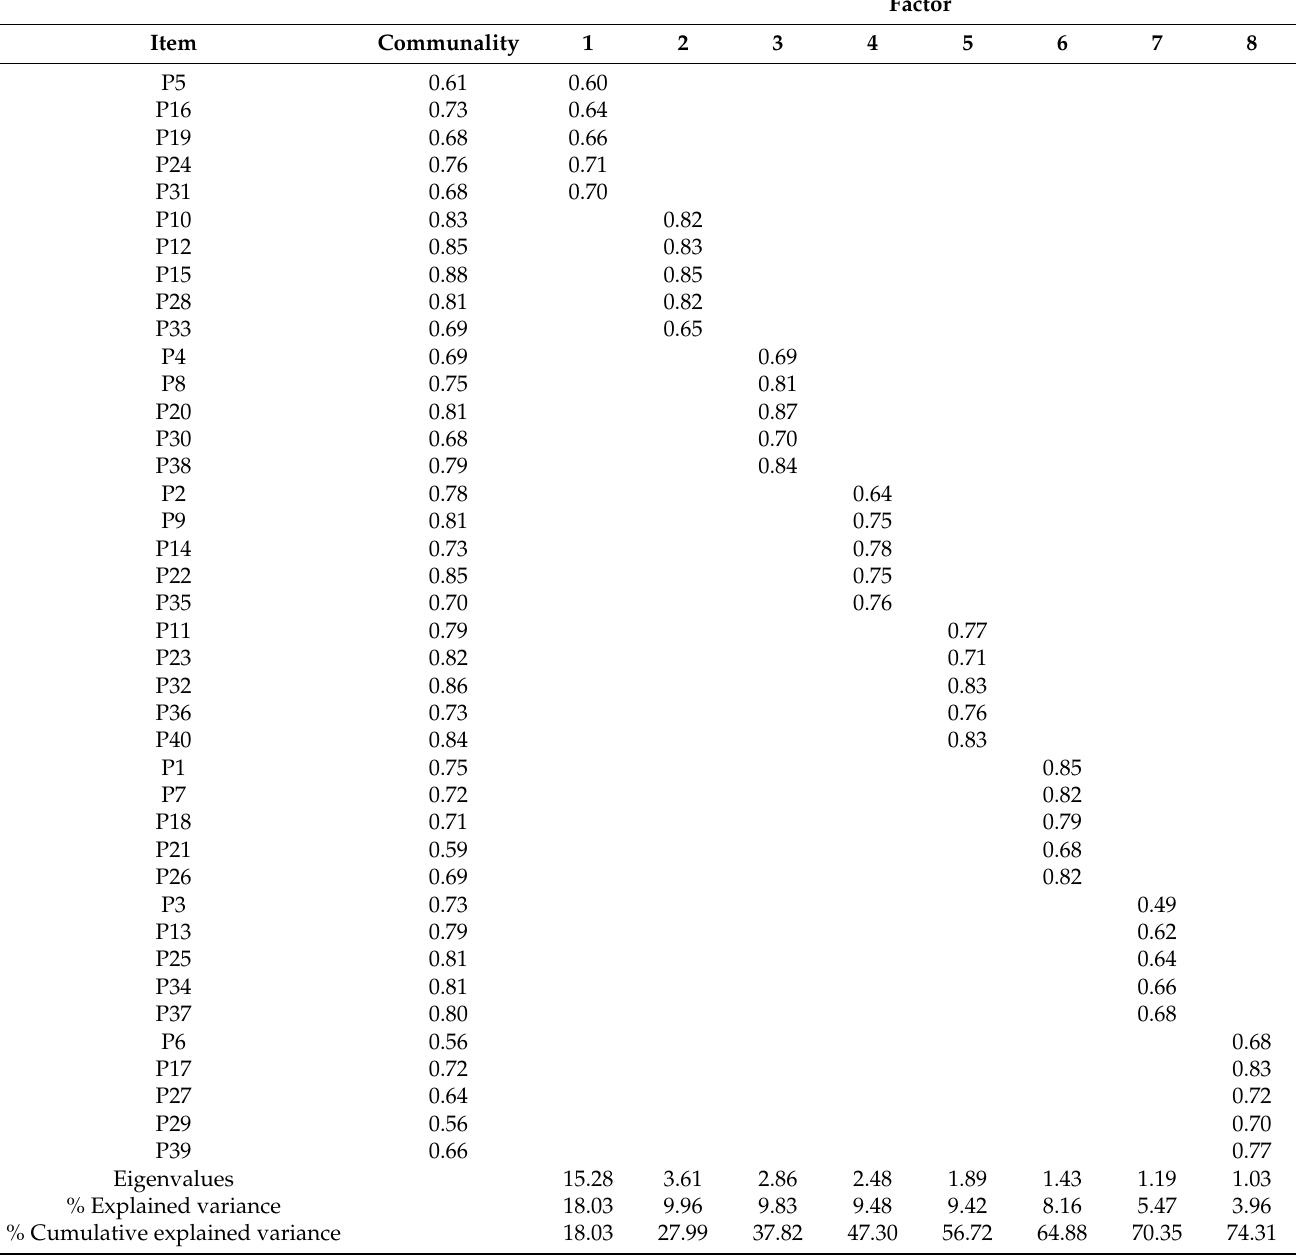
Table 2. Exploratory factor